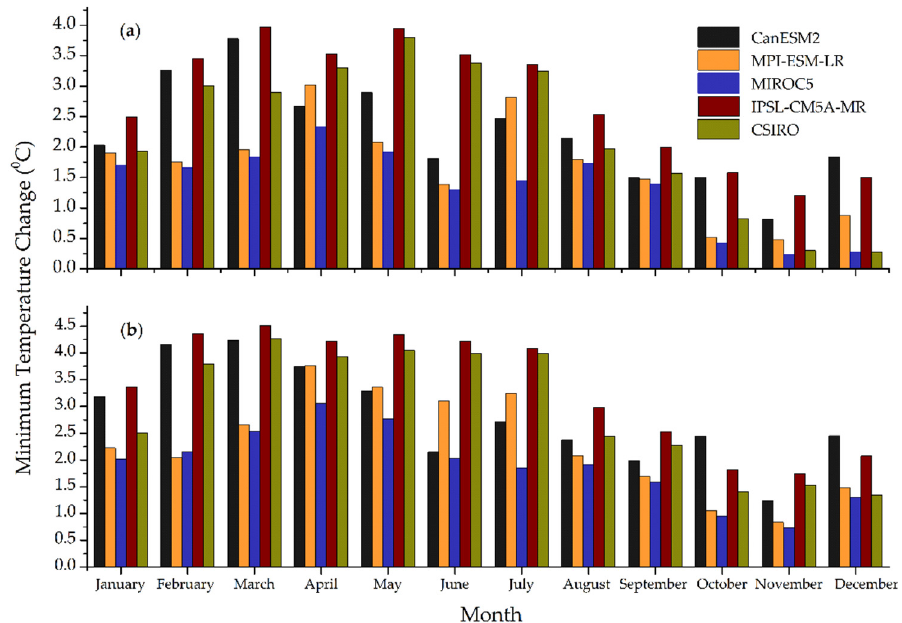
Figure 11. Changes in monthly minimum temperature of the near future period from 2021–2050, with respect to the baseline obtained with: ( a ) RCP4.5; and ( b ) RCP8.5.